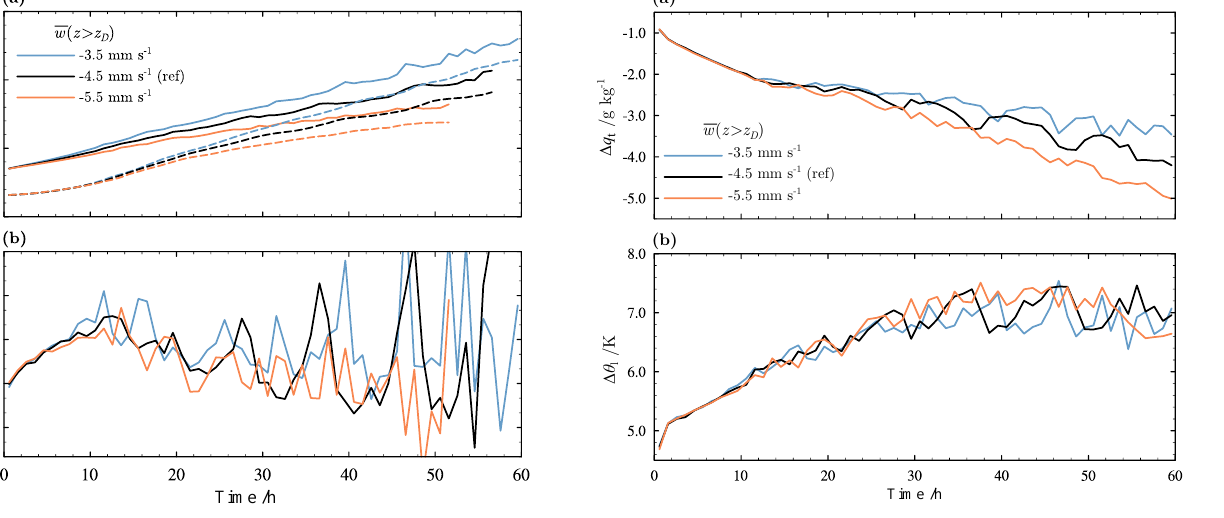
Figure 4. (a) The stratocumulus top (solid) and base height (dashed) and (b) the entrainment velocity as a function of time for the subsi- dence sensitivity simulations.